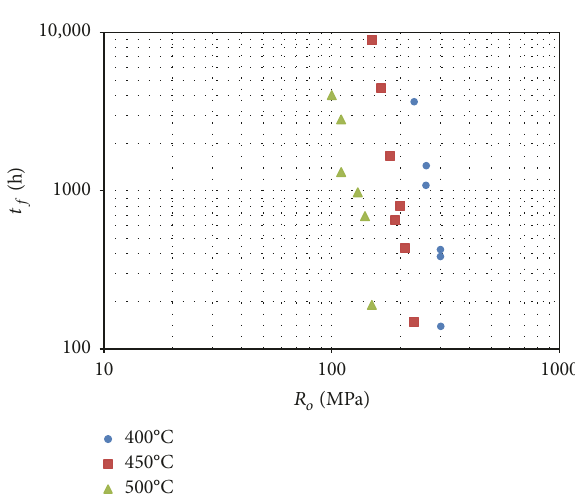
Figure 2: Dependence of the time to fracture ( 𝑡 𝑓 ) on the nominal stress ( 𝑅 𝑜 ) for H300LAD